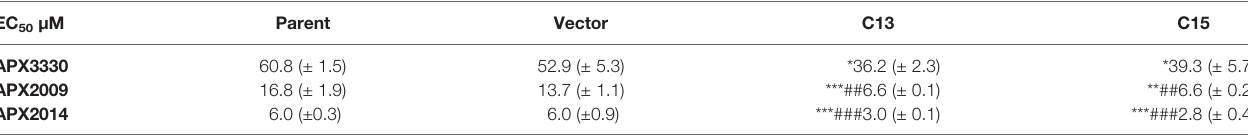
TABLE 1 | EC 50 (µM) summary table of APX3330, APX2009, APX2014 cytotoxicity assays in KC3590 lines.